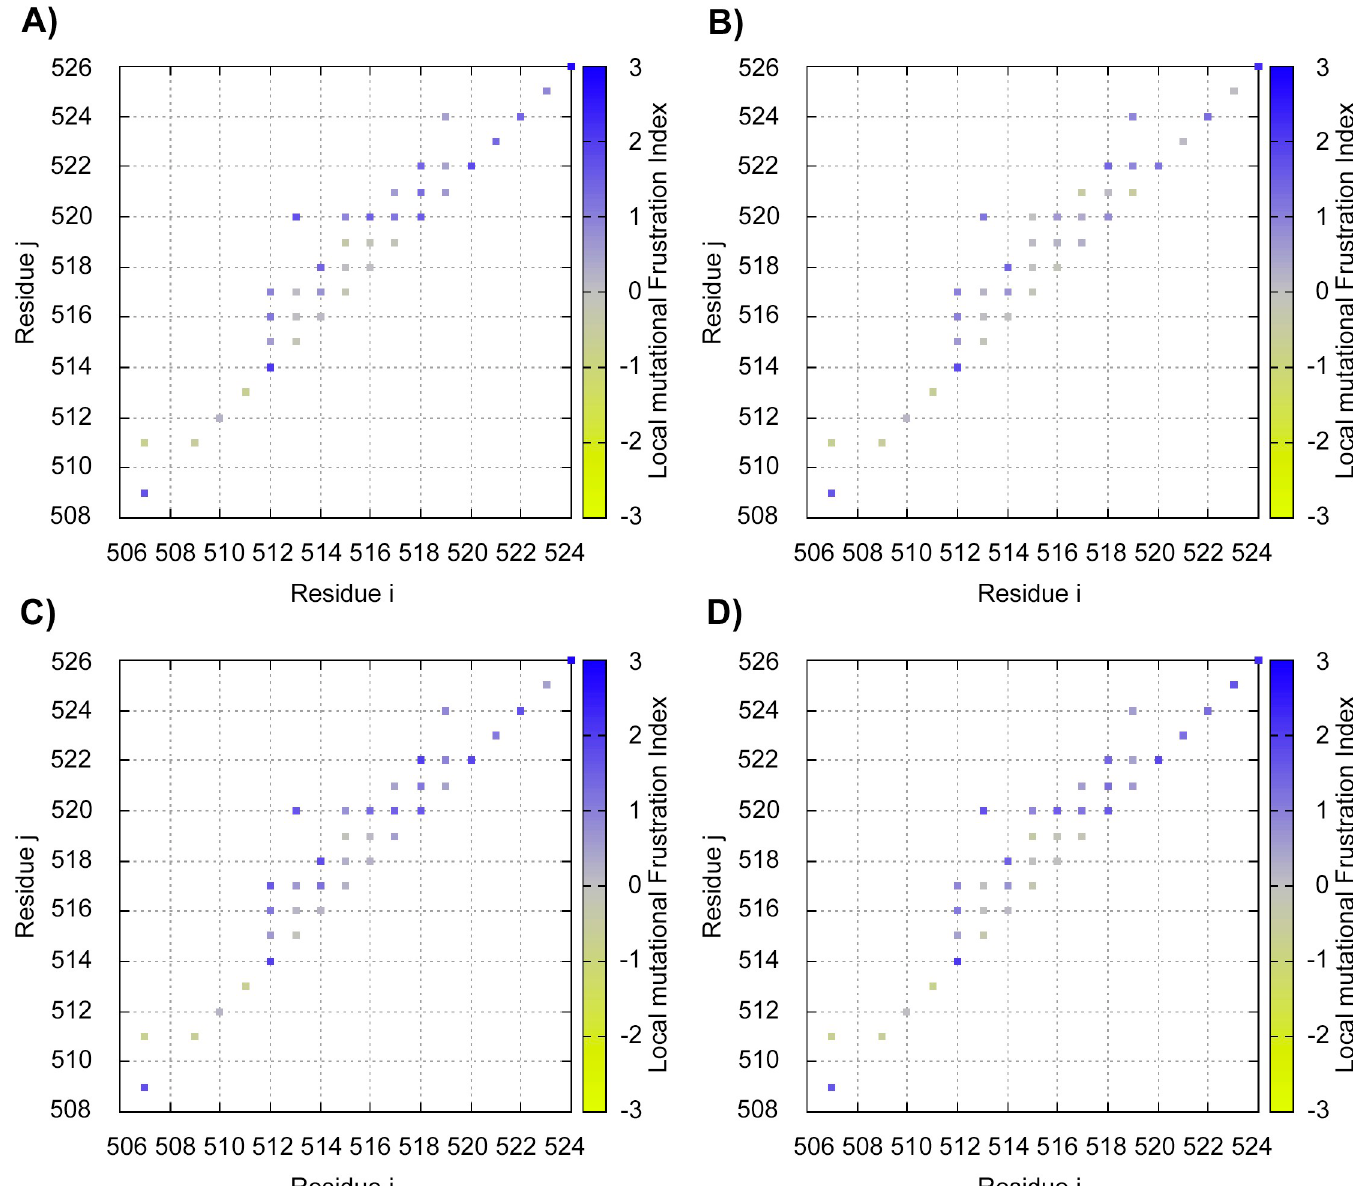
Fig 2. Mutational frustration analysis. Levels of mutational frustration by each residue-residue interaction. The colored scale represents the levels of frustration, in which blue represents minimal frustration, gray represents neutral frustration, and yellow represents high frustration. A) Wild-type FUS. B) R521C variant. C) R521H variant. D) P525L